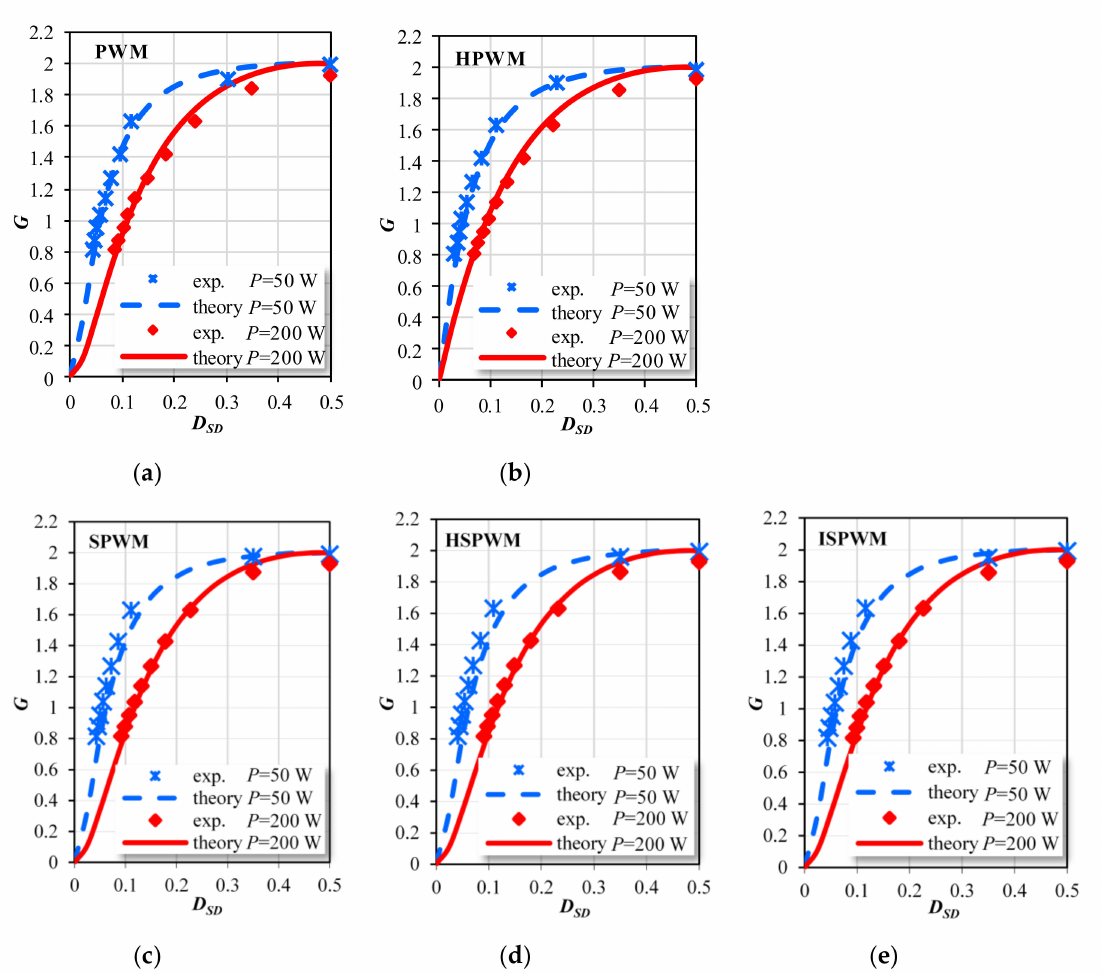
Figure 9. Normalized voltage gain of the case study SRC for PWM ( a ), HPWM ( b ), SPWM ( c ), HSPWM ( d ), and ISPWM ( e ) control